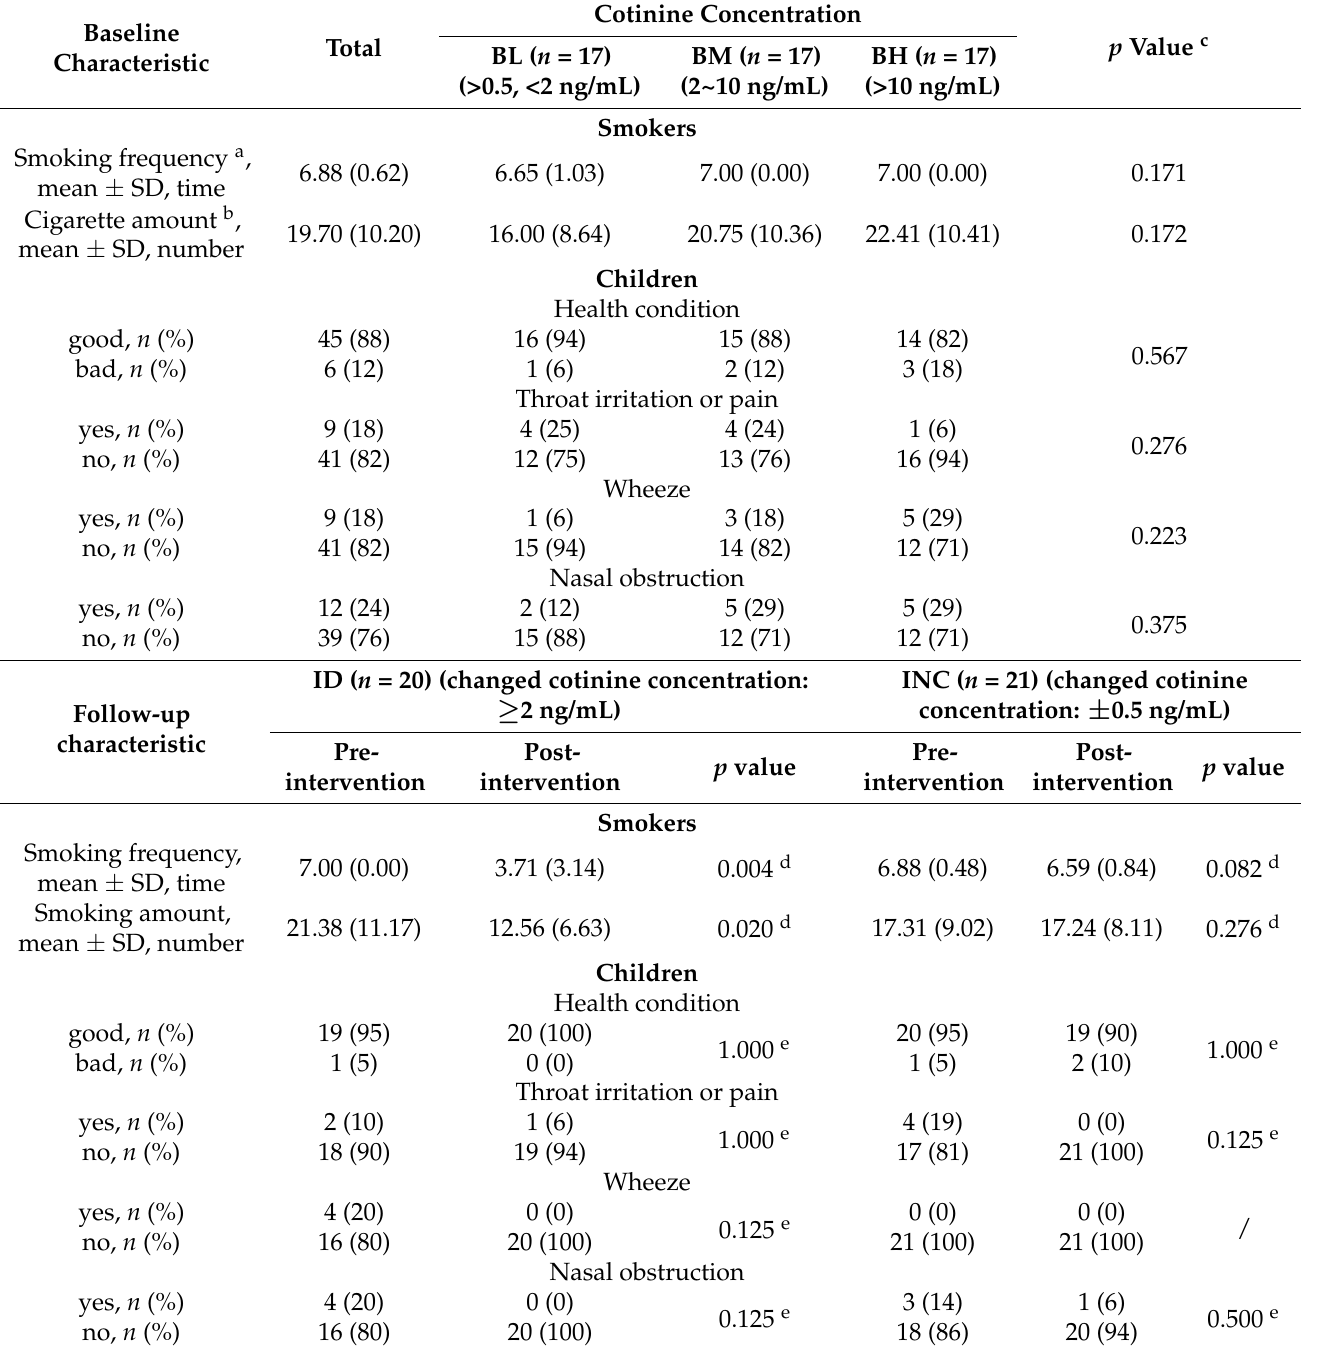
Table 1. Smoking behavior of smokers and the health status of children at the baseline and